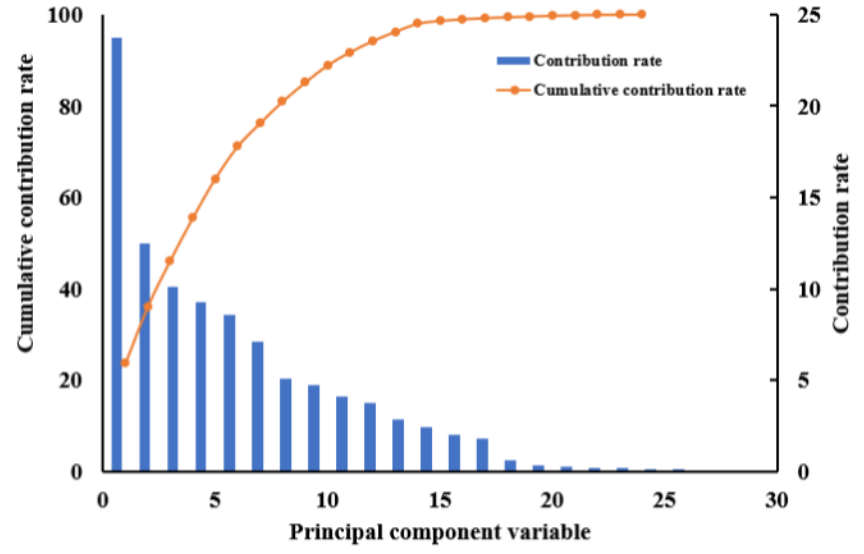
Figure 5. Contribution rate of the principal components.